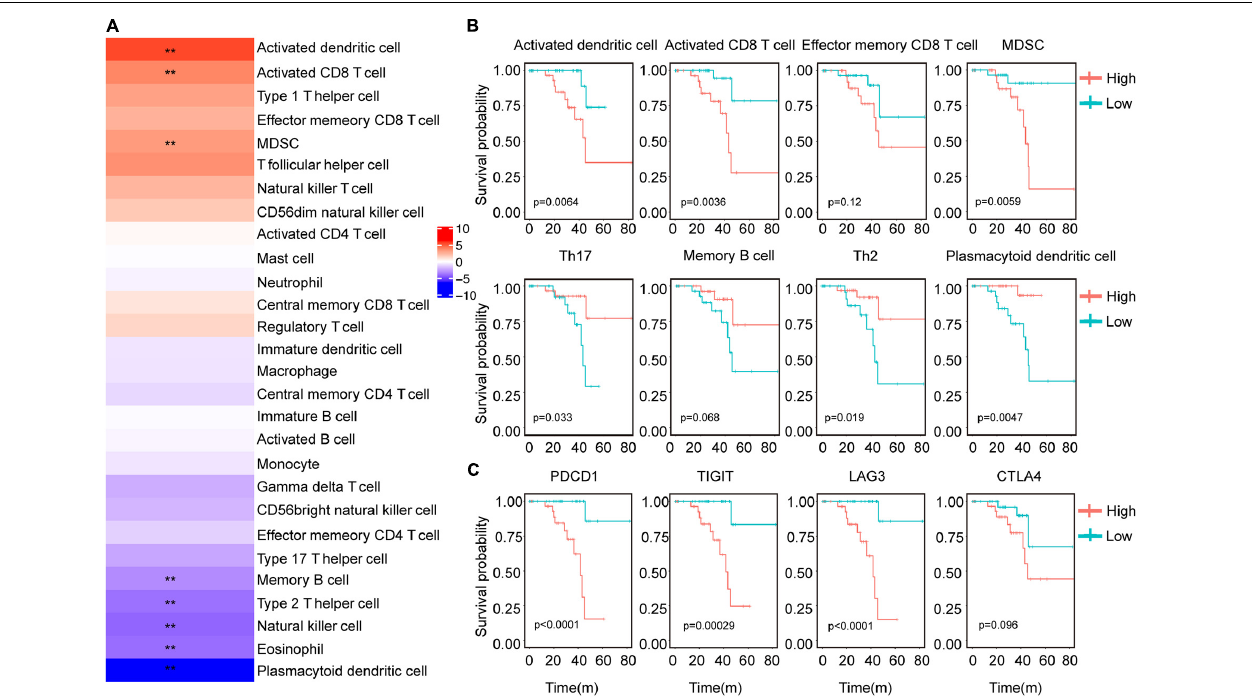
FIGURE 2 | Correlation between immune characteristics and clinical outcomes of UVM. (A) Heatmap showed the risk ratio of the immune cell characteristic score in the immune subtypes. (B) Kaplan–Meier analysis of the correlation between the scores of activated CD8 T cells, Th1 cells, Th2 cells, Th17 cells, NK cells, activated B cells, and OS. (C) Kaplan–Meier analysis of the correlation between gene expression of LAG3 , PDCD1 , TIGIT , and OS. The expression above the median is high and below the median is low. ** P <